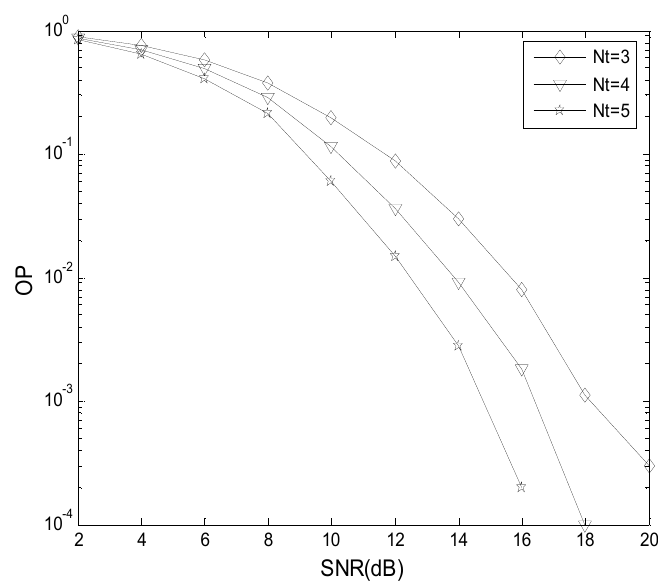
Figure 5. The effect of N t on OP performance.